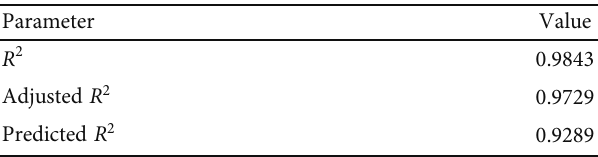
Table 10: Model fi t statistics for the reduced model (Source: Design-Expert 13